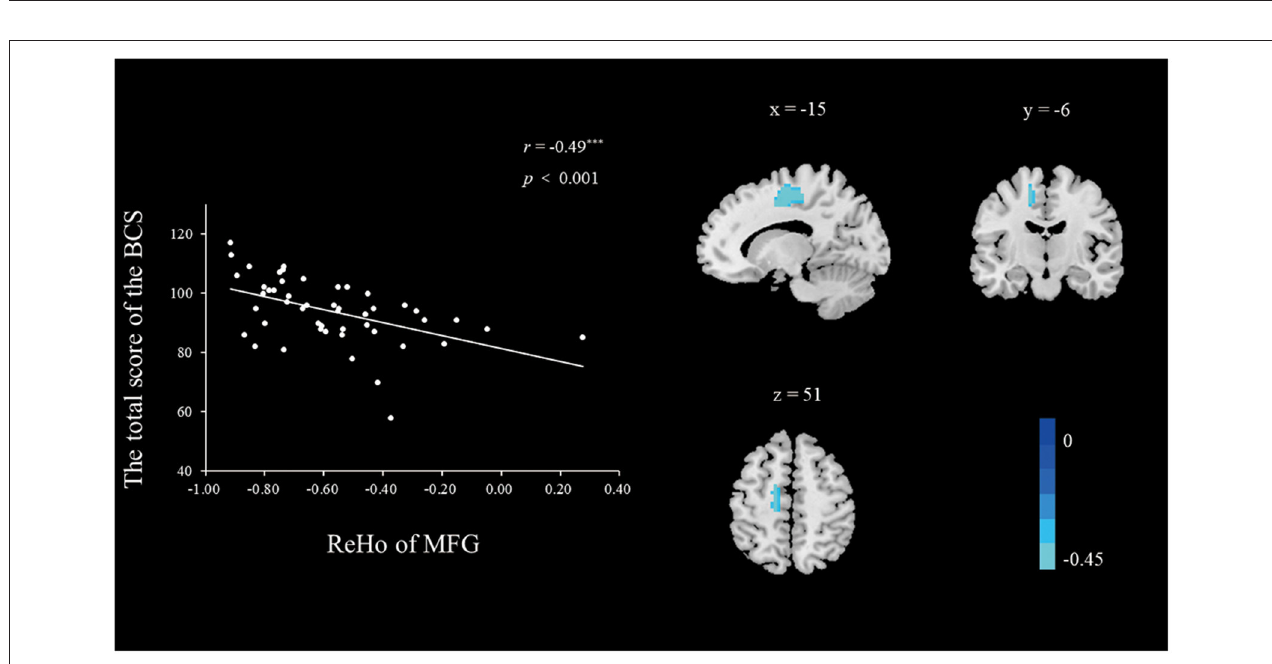
FIGURE 1 | The brain regions with significant correlations between the ReHo and the BCS (right panel). The ReHo in the left thalamus was positively correlated with the BCS (left panel). The scatter plots depicted correlations between the ReHo in the left thalamus and individual differences in the BCS scores. Height and extent thresholds were set at p < 0.01, corrected.